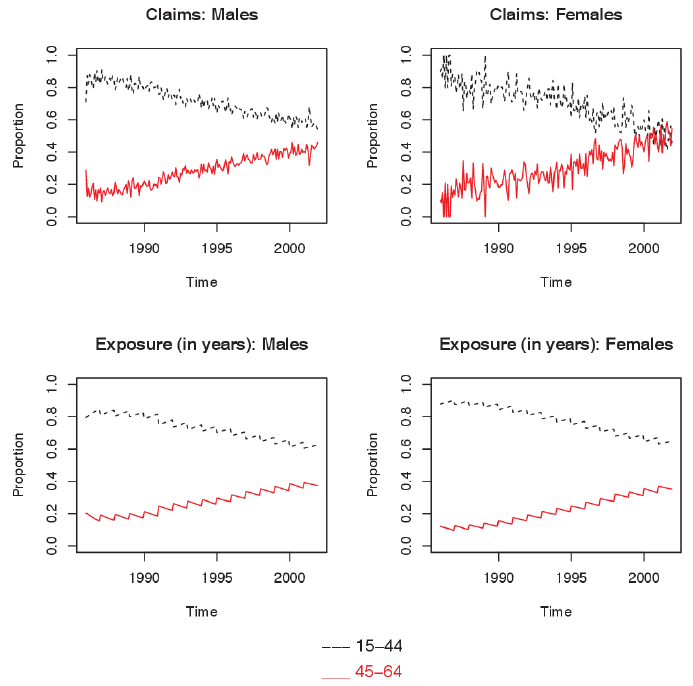
Figure 1. Insured population by age: composition over time, by claims and by